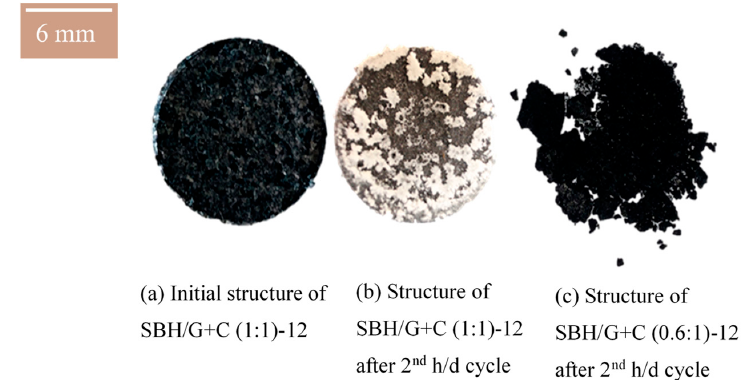
Figure 8. Twelve-millimeter diameter pellets. SBH / G + C (1:1)-12 before (left) and after (middle) 2nd hydration / dehydration cyclic test. SBH / G + C (0.6:1)-12 pellet after 2nd hydration / dehydration test (right).